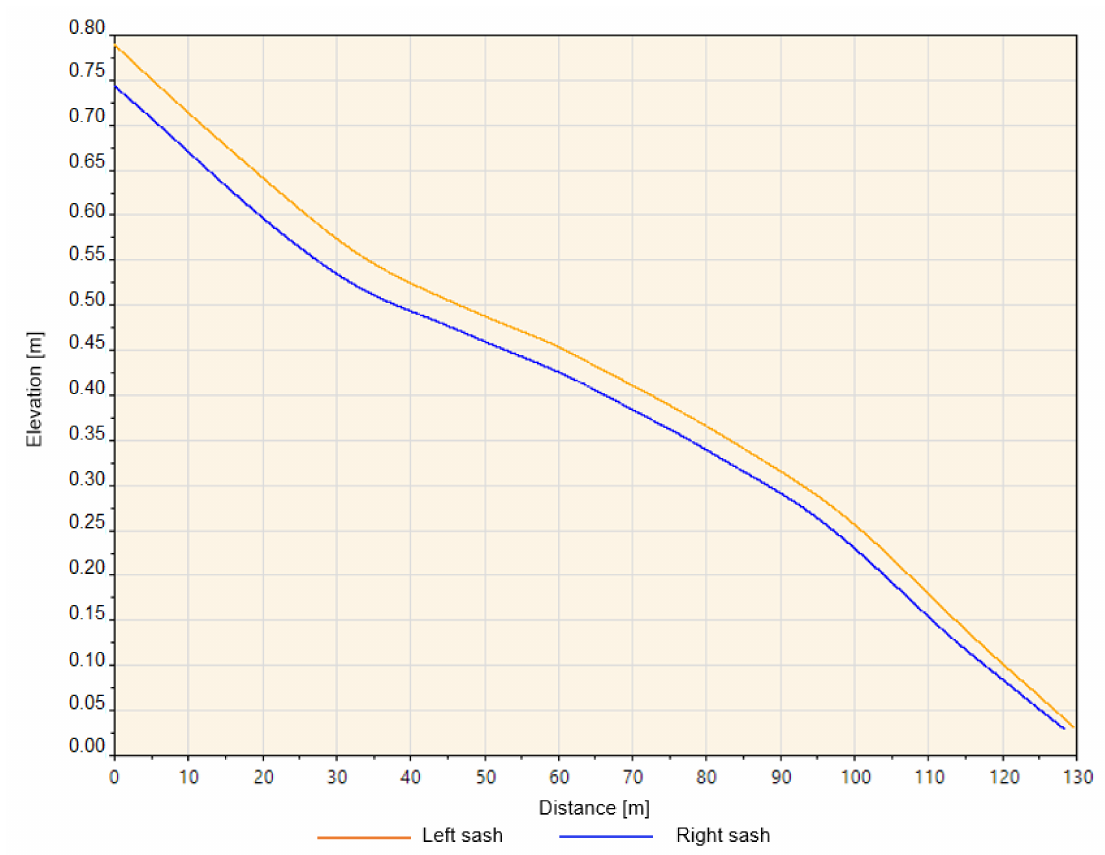
Figure 13. Longitudinal profiles for left and right sashes.